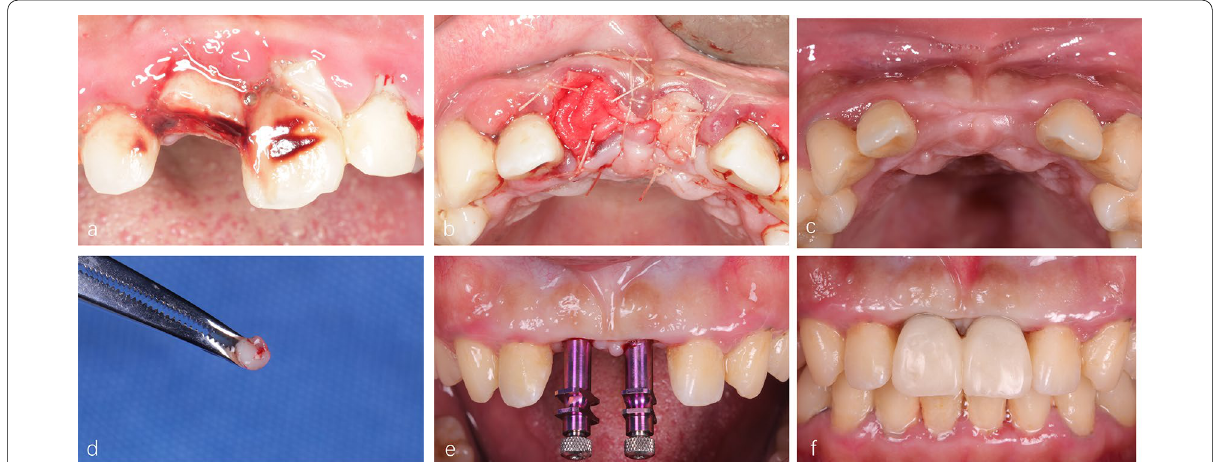
Fig. 1 The process of ARP. a Clinical conditions at baseline; b 100 mg Bio-oss ® Collagen was placed in both extraction sockets, 11 surfaces were covered with Bio-Gide ® collagen membranes, 21 were covered with CGFs membranes; c clinical conditions at the 6-month follow-up; d the soft tissue sample from implant surgery; e , f the initial stability of the two implants during the operation was greater than 35 Ncm, the immediate postoperative repair was selected